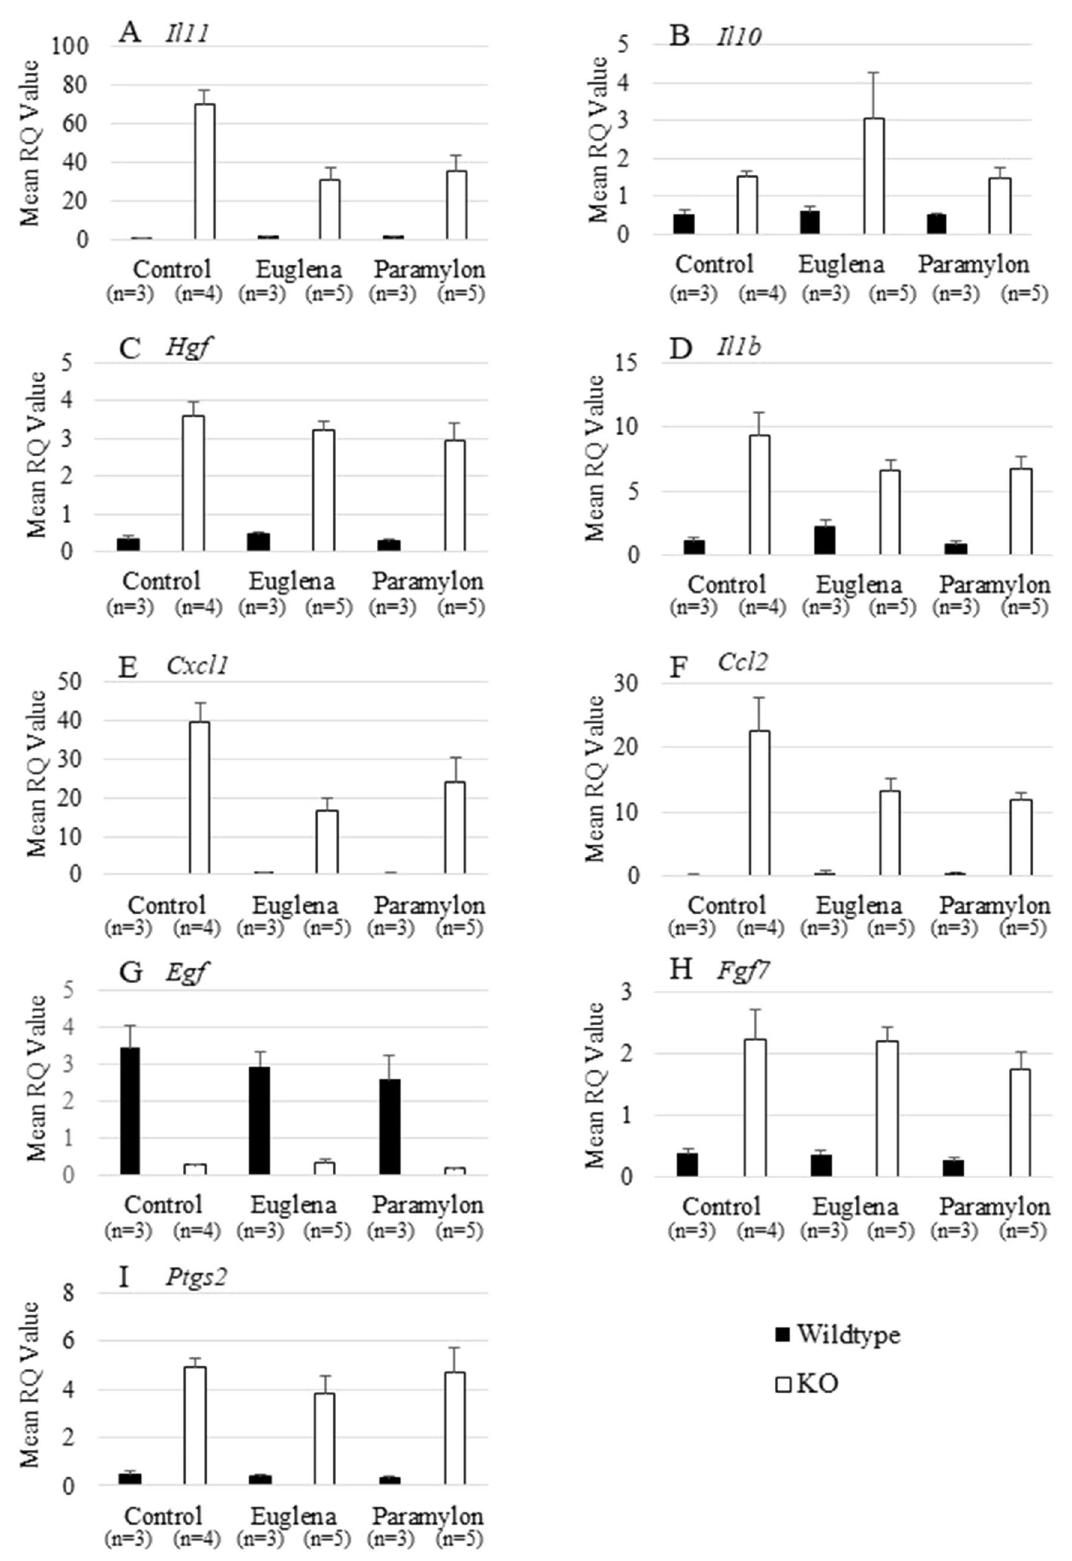
Figure 6. Mean gene expression levels of selected cytokines whose expressions are reported to be substantially altered following A4gnt KO-induced gastric carcinogenesis. ( A ) Il1 , ( B ) Il10 , ( C ) Hgf , ( D ) Il11b , ( E ) Cxcl1 , ( F ) Ccl2 , ( G ) Egf , ( H ) Fgf7 , (I) Ptgs2 . The expressions of gene studied were significantly higher in A4gnt KO mice than those in wildtype mice except for the expression of Egf whose expression was significantly lower in A4gnt KO mice. Administration of Euglena and paramylon significantly reduced the expressions of Il11 , Cxcl1 and Ccl2